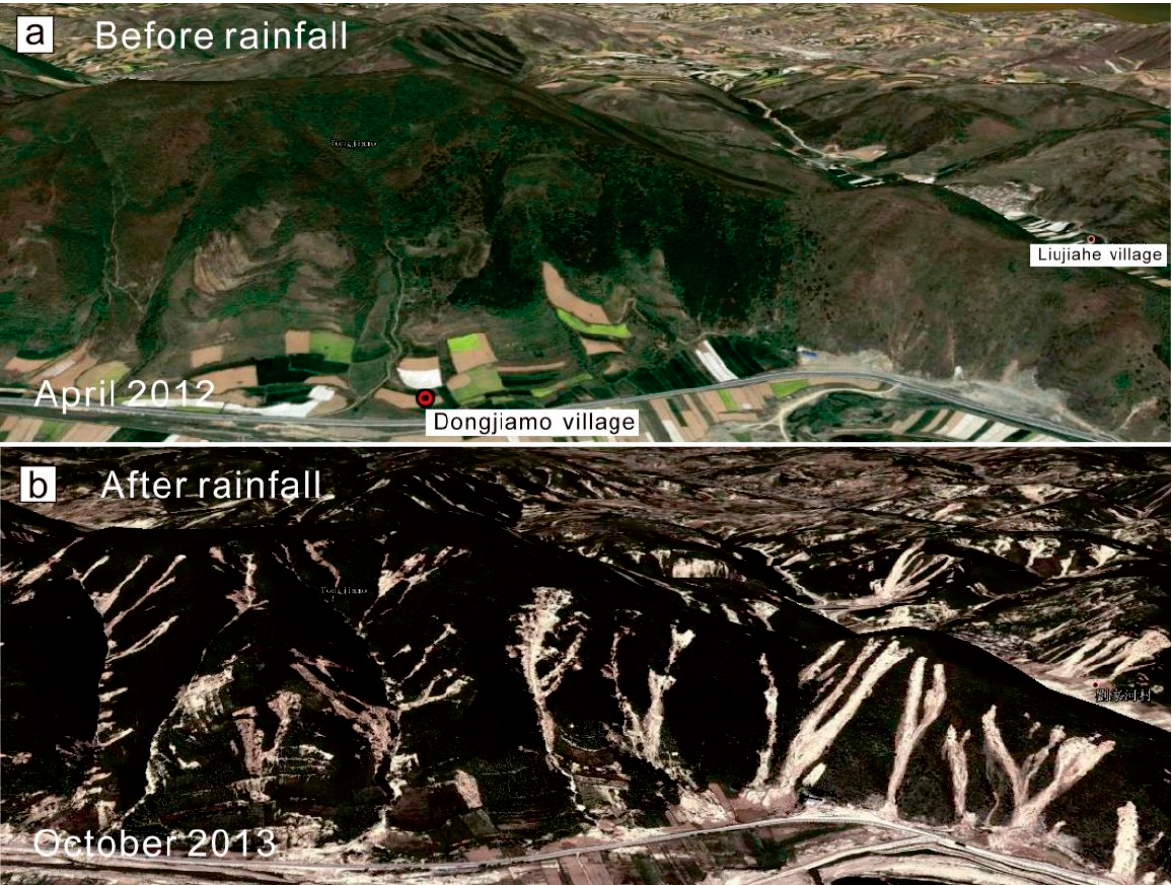
Figure 2. An example of the comparison of Google earth images before and after rainfall in the same area.